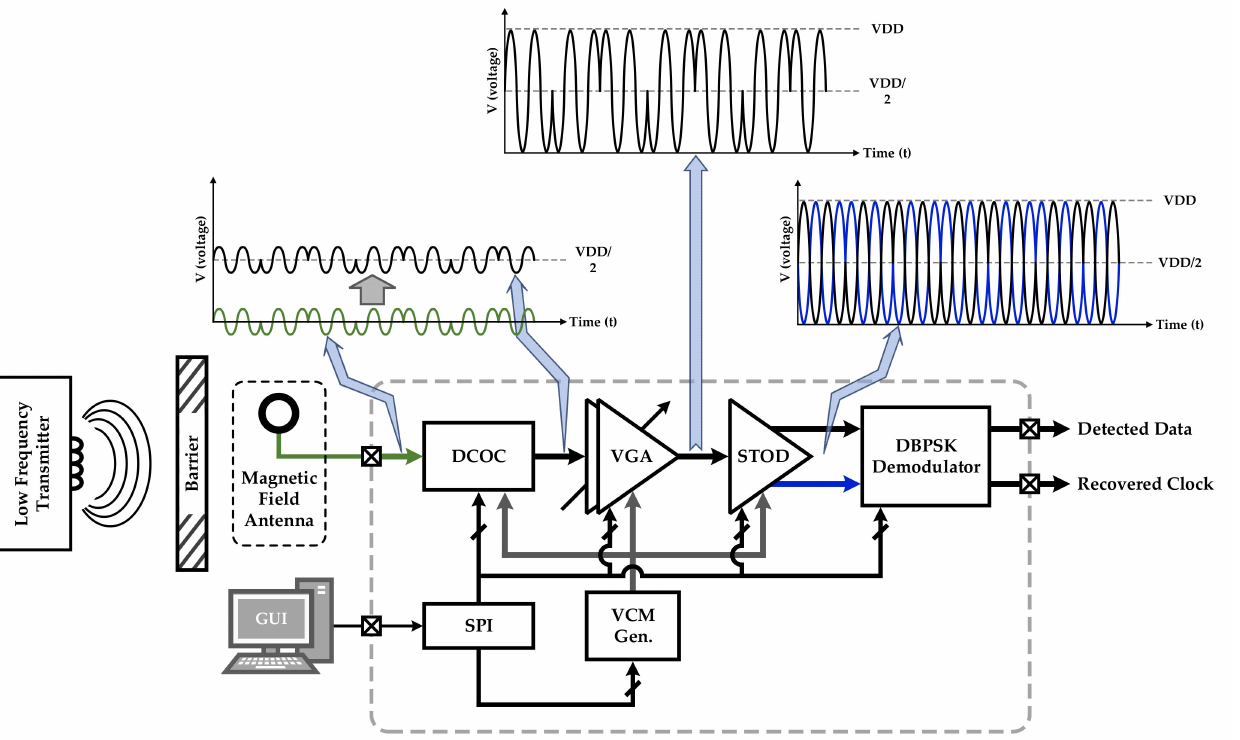
Figure 1. Architecture of the proposed